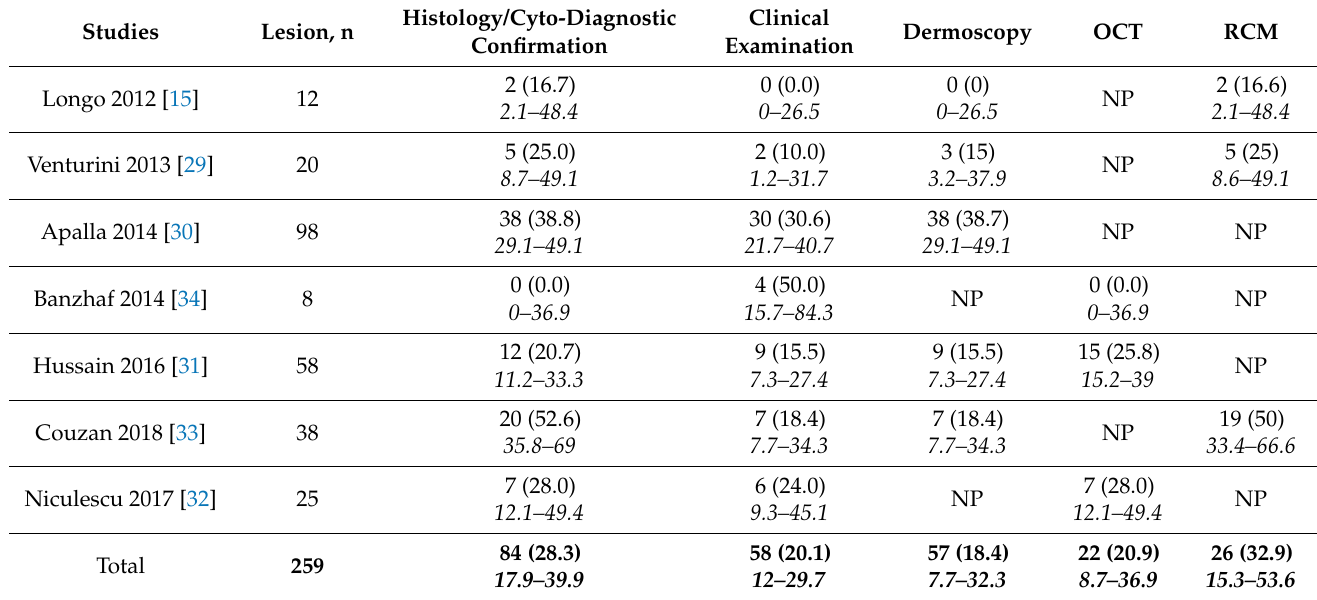
Table 2. Individual studies NMSC persistent estimates with histopathology, clinical examination and all noninvasive diagnostic and imaging